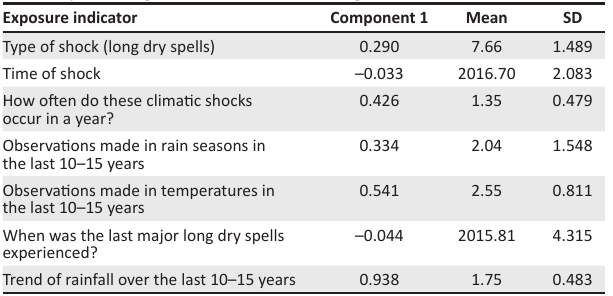
TABLE 1: Factor loadings for exposure of small-scale sorghum farmers to climate variability in the highlands of south-western